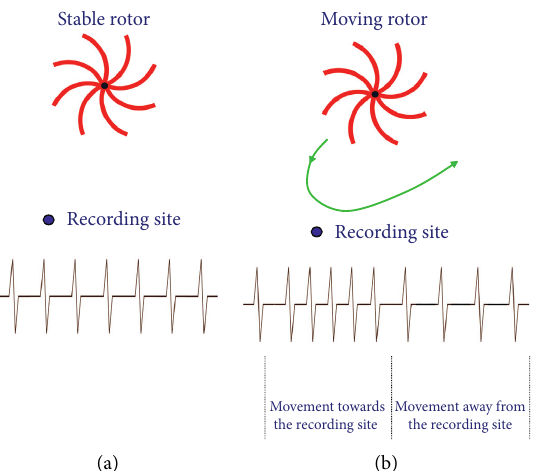
Figure 6: Doppler-type effect with an increase and decrease in the depolarization frequency when the rotor is moving [28]. (a) Stable rotor. (b) Moving rotor.